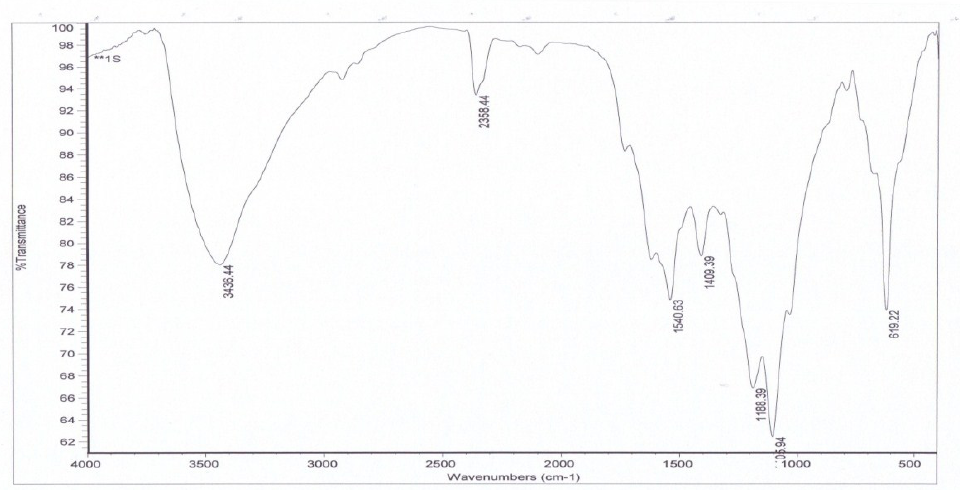
Figure 1 A .FTIR spectrum of reactive blue MXR.